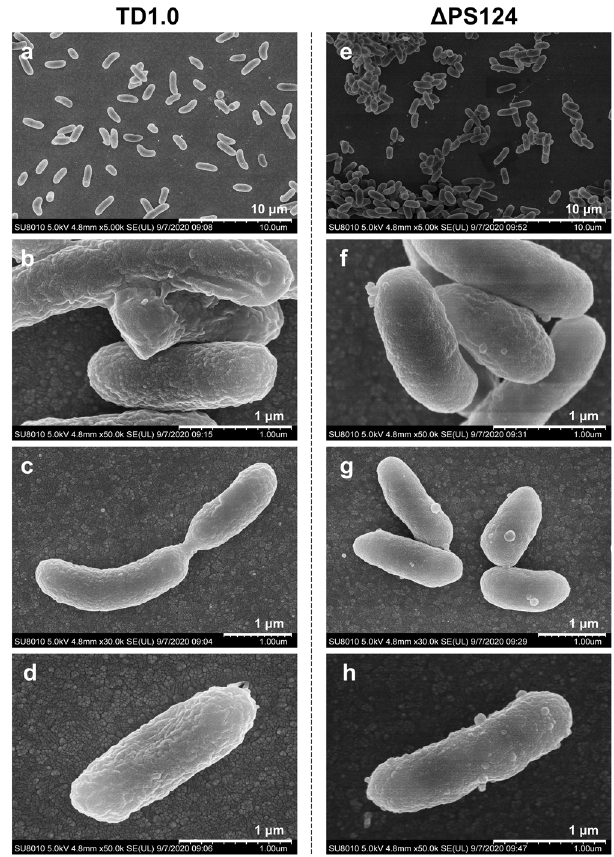
Fig. 4 SEM images of TD1.0 and Δ PS124. Strains TD1.0 ( a – d ) and Δ PS124 ( e – h ) were cultured in LB60 medium for 24 h before fi xation. TD1.0, H . bluephagenesis TD1.0; Δ PS124, H . bluephagenesis TD1.0 with deletion of PS1, PS2 and PS4 gene